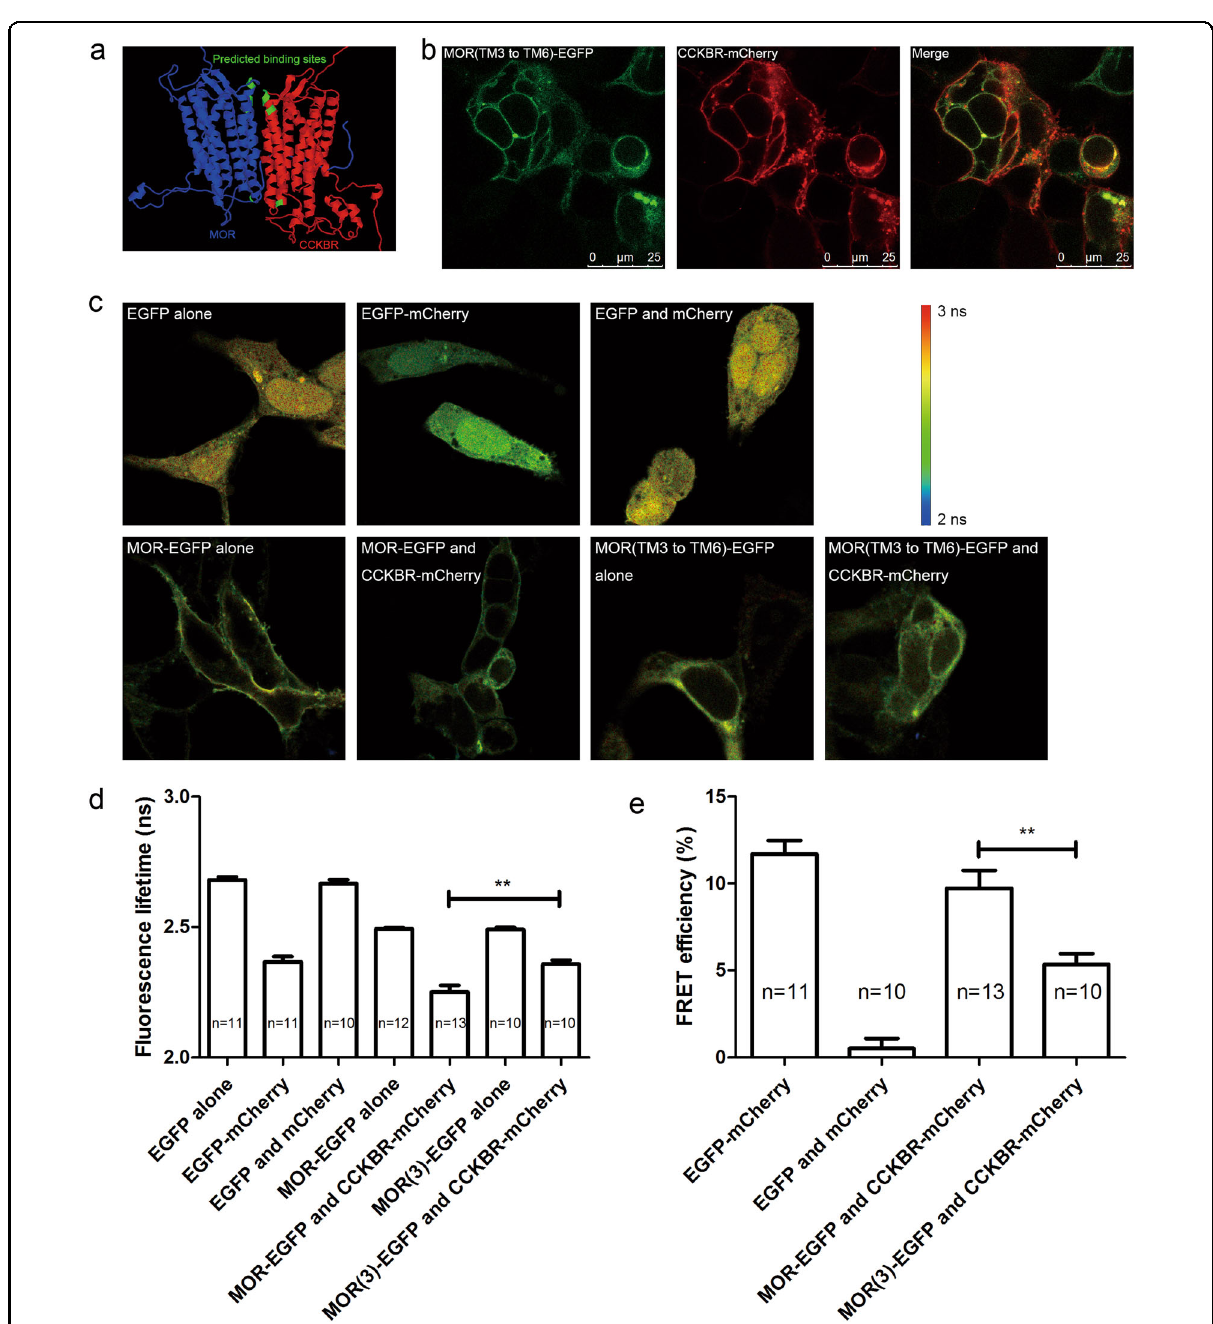
Fig. 3 Transmembrane domain 3 (TM3) of MOR participated in the heteromerization of MOR and CCKBR. a The computational predicted model of the MOR – CCKBR complex structure. The blue- and red-colored structures represent MOR and CCKBR, respectively. The green domains represent receptor – receptor-binding sites. b Expression and colocalization of MOR (TM3 replaced with TM6)-EGFP and CCKBR-mCherry in HEK293 cells. c FLIM images of EGFP alone or linked with mutant MOR or wild-type MOR in different overexpressing HEK293 cells. The lifetime of MOR-EGFP co-expressed with CCKBR-mCherry was shorter than that of MOR-EGFP expression alone, as indicated by a blueshift in the color. However, mutant MOR co-expressed with CCKBR-mCherry did not show signi fi cant blueshifting compared with the group expressing mutant MOR alone. d Statistics of EGFP fl uorescence lifetime in ( c ). e FRET ef fi ciency showed a signi fi cant decrease in energy transfer between mutant MOR-EGFP and CCKBR-mCherry. ** p < 0.01, t- test. Data are represented as the mean ±